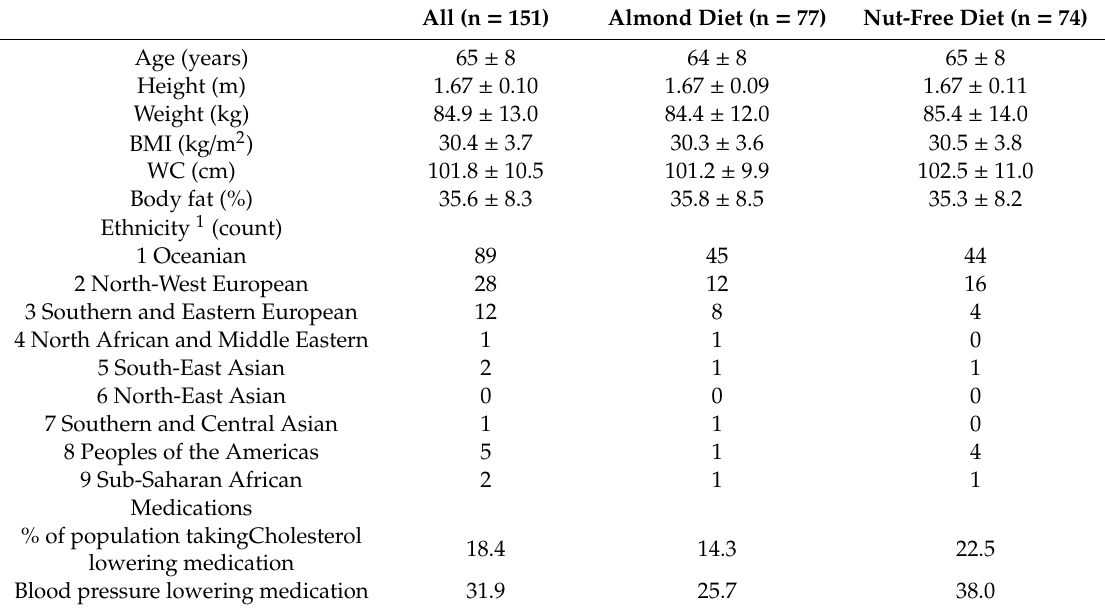
Table 1. Baseline demographics of study